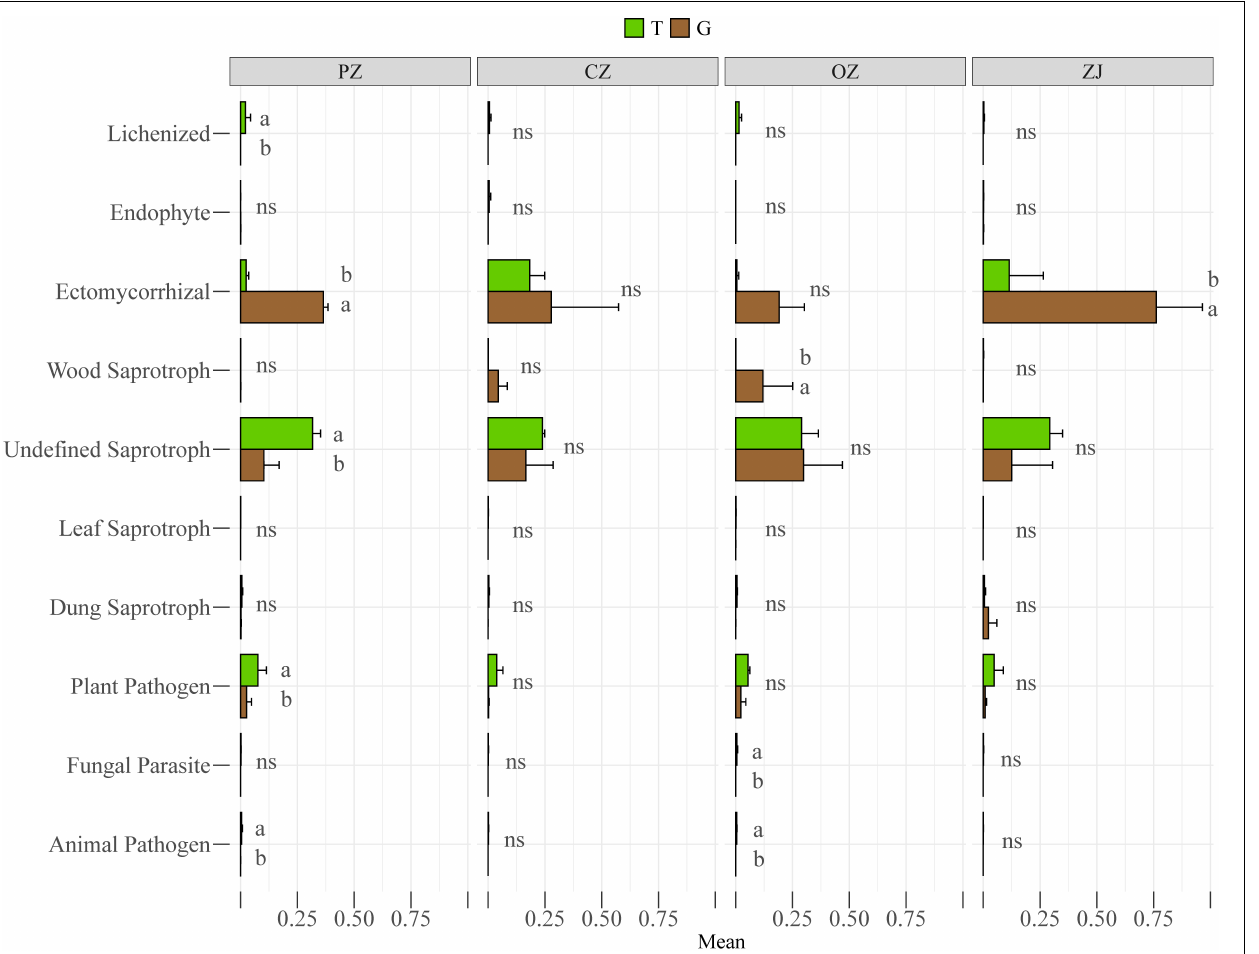
FIGURE 3 | Functional features of fungal communities in four hazelnut species in the rhizosphere soil (T) and root endospheres (G). Different letters (a,b) indicate the significance level at P < 0.05, “ns” indicates no significance ( P >